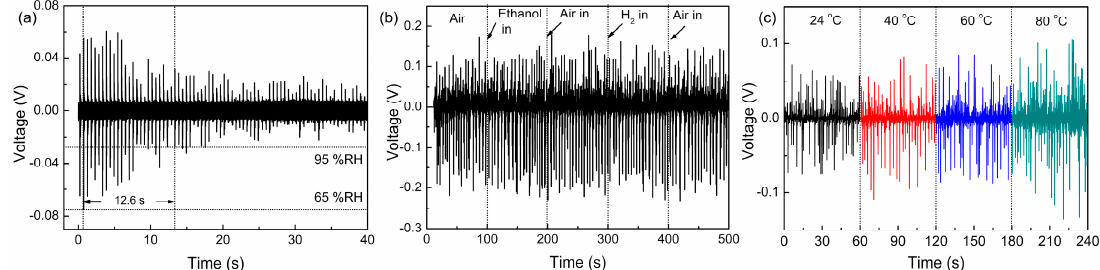
Figure 8. ( a ) The transient response of the sensor when the humidity increased from 65% to 95% RH. ( b ) The transient response of the sensor when ethanol steam and H 2 was introduced and removed, respectively. ( c ) The output voltage of the sensor at 38% RH under different temperature.